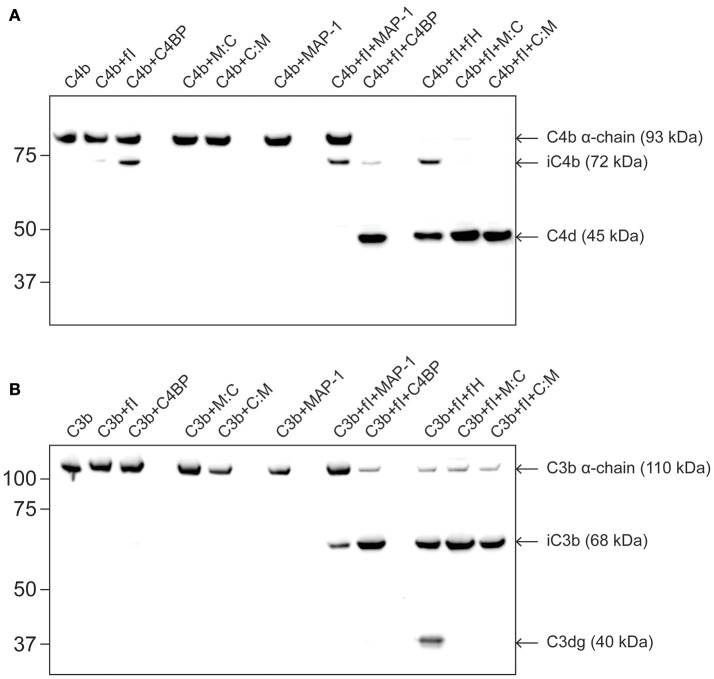
Cofactor activity in factor I-mediated C4b and C3b cleavage. Purified C3b or C4b was incubated with fI and different cofactors for 2 h at 37°C. The reactions were stopped with LDS buffer and subjected to western blotting under reducing conditions using C4d and C3d antibodies. (A) Incubation of C4b with fI in the presence of C4BP, fH or C4BP-containing chimeric proteins resulted in the generation of a band corresponding to the inactive degradation products iC4b and C4d. (B) Incubation of C3b with fI in the presence of C4BP, fH or C4BP-containing chimeric proteins results in the generation of the 68 kDa degradation fragment. M:C, MAP-1:C4BP1−5; C:M, C4BP1−5:MAP-1. The blots are representative of three independent experiments.